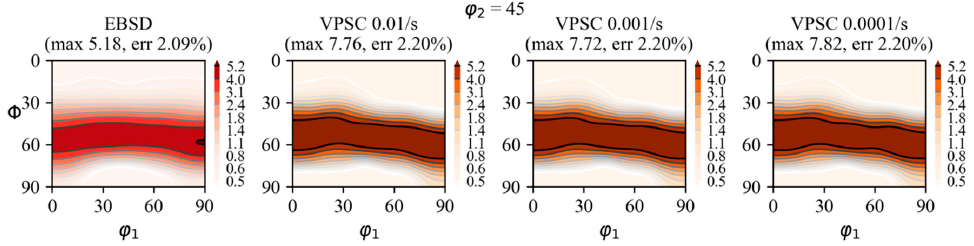
Figure 13. Comparison between deformed texture after uniaxial tension of dog bone specimen deformation 15% at 0.005/s) and DAMASK simulation (deformation: 15% and different strain rates), using parameters fitted with RVE 20 ODF.